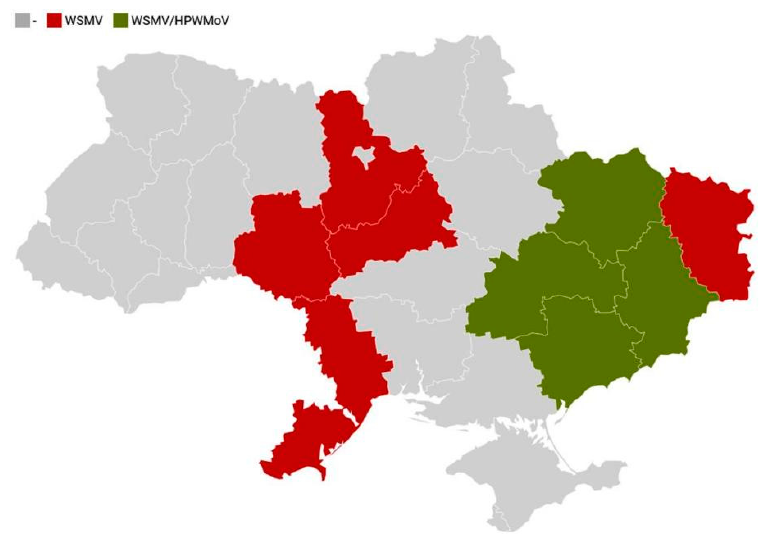
Figure 3. Schematic map of Ukraine showing regions where wheat streak mosaic virus (WSMV) only (red color) or WSMV and High Plains wheat mosaic virus (HPWMoV) (green color) were detected in this study. The map was generated using DataWrapper service (www.datawrapper.de, accessed on 1 April